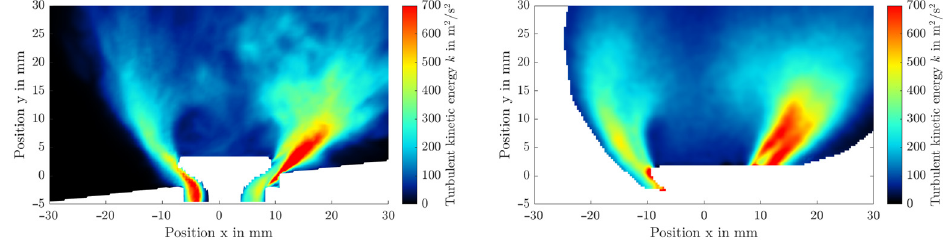
Figure 14. Turbulent kinetic energy at 4 mm and 39.6 kg/h, LES ( left ) and PIV results ( right ).